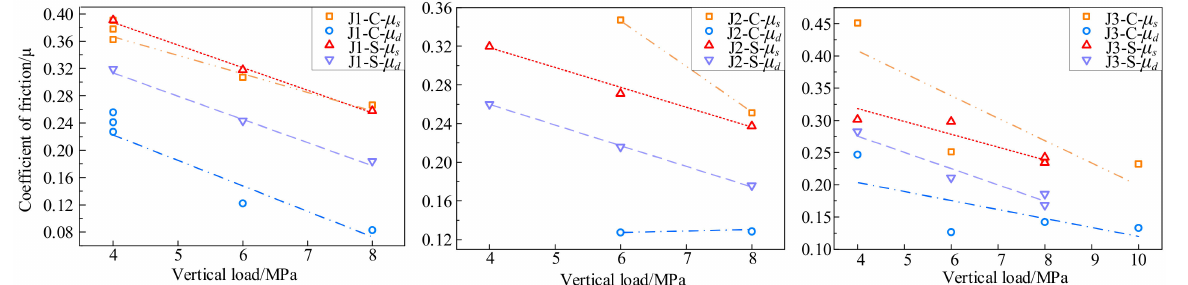
Figure 10. Variation of LRB friction coefficient with vertical loads.